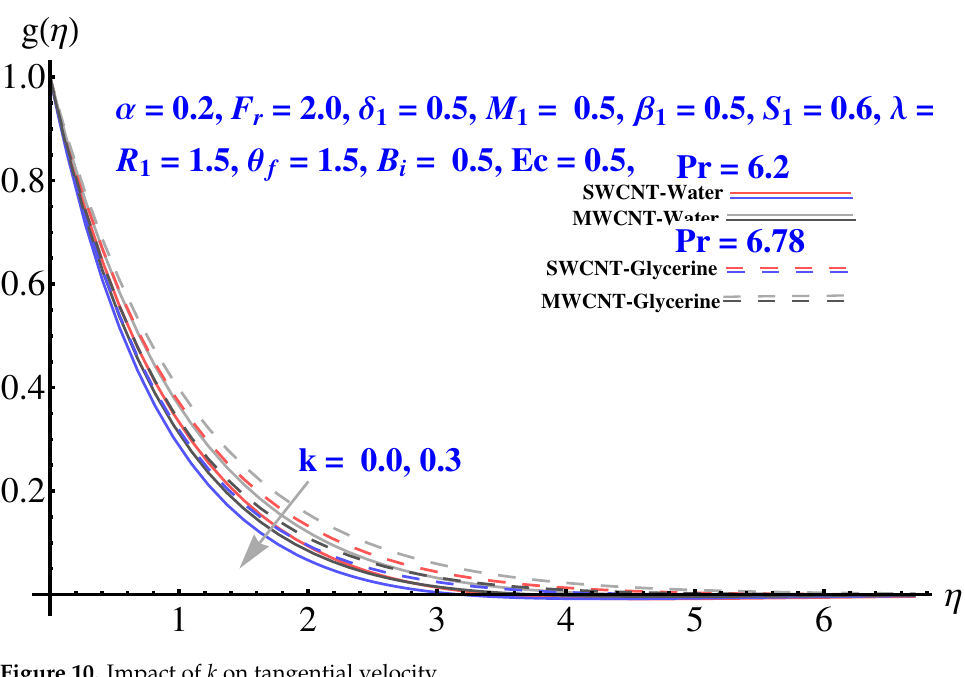
Figure 10. Impact of k on tangential